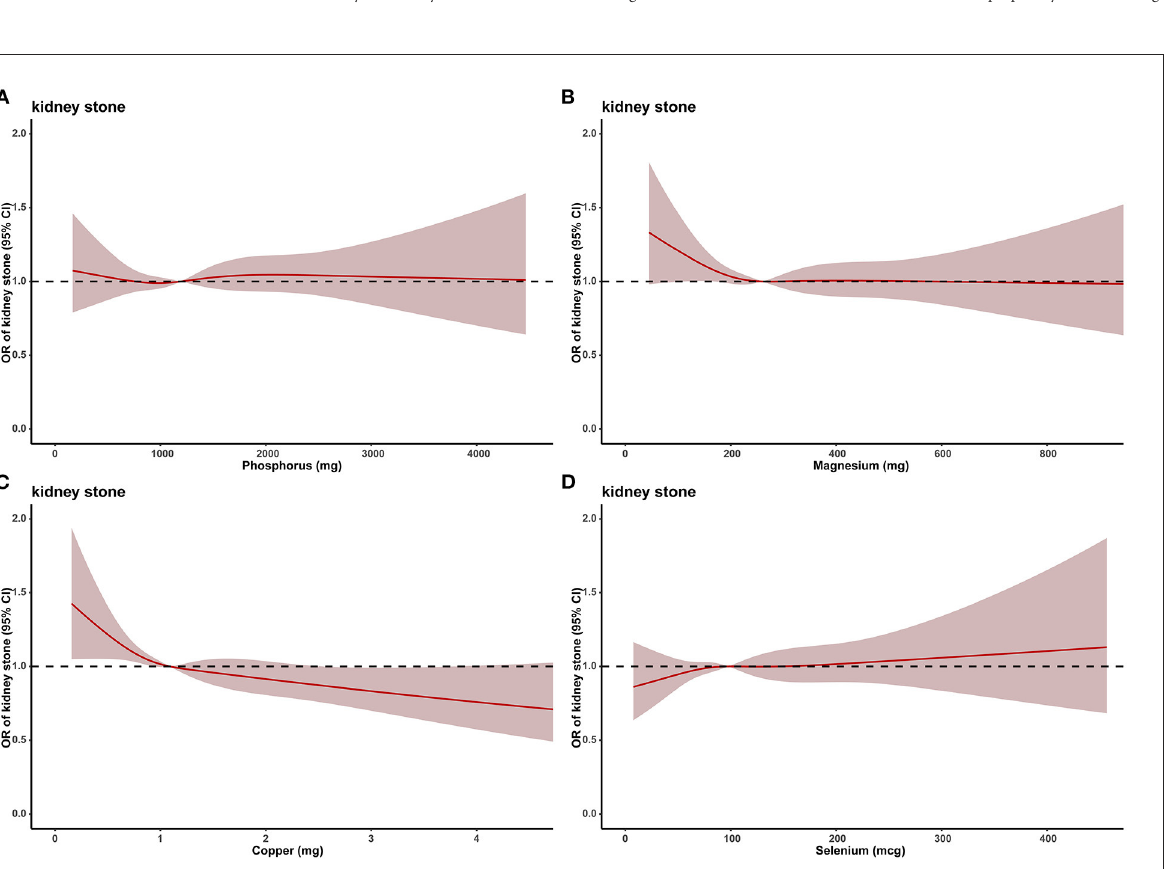
FIGURE4 The dose–response analysis between dietary metal intake and presence of kidney stones after propensity score matching. (A) Phosphorus. (B) Magnesium. (C) Copper. (D)